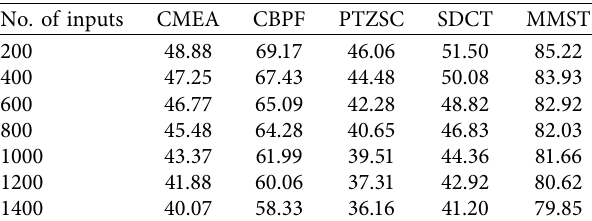
Table 4: Comparison of plant nutrition management.